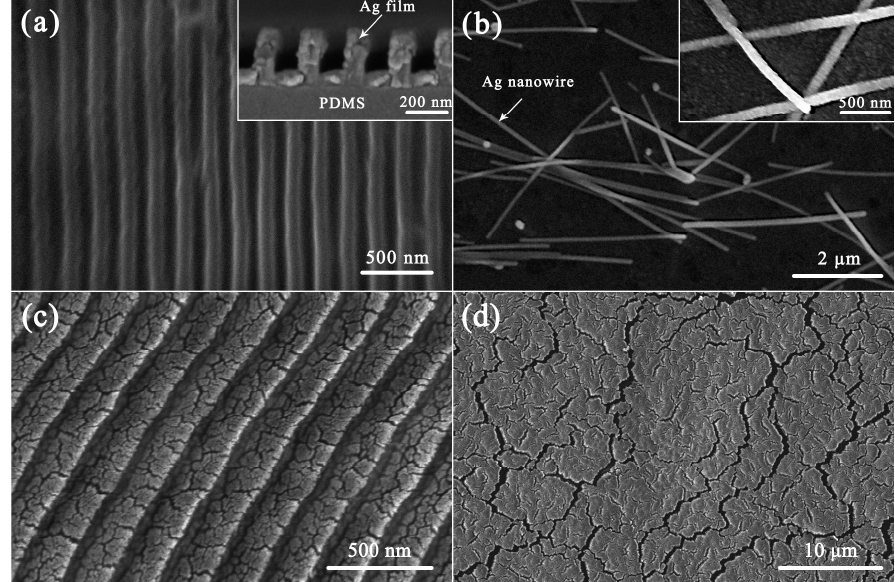
Figure 2. The scanning electron microscope (SEM) images of the fabricated composite films for the initial state: ( a ) Ag/nanoimprinted polydimethylsiloxane (PDMS) and ( b ) Ag/AgNW-treated PDMS. The SEM images of the fabricated composite films after cyclic loading: ( c ) Ag/nanoimprinted PDMS and ( d ) bare Ag/PDMS.